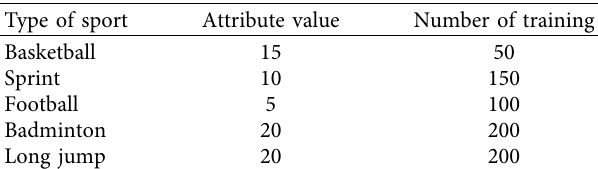
Table 3: Experimental dataset of sports teaching